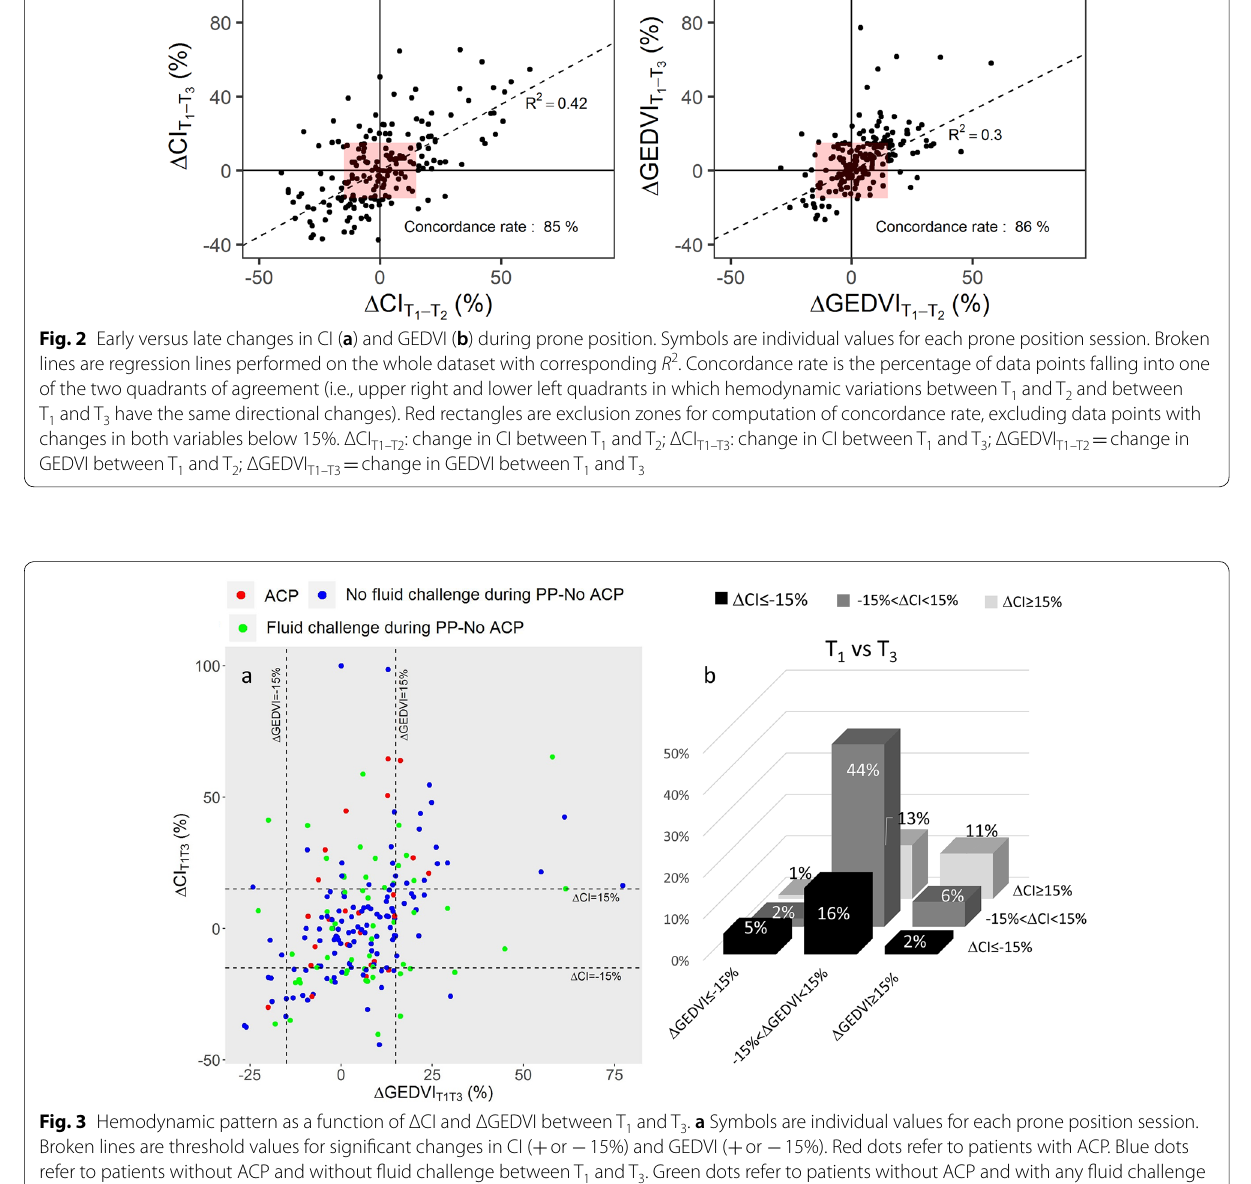
or 15%) and GEDVI ( or 15%). Red dots refer to patients with ACP. Blue dots + − + −